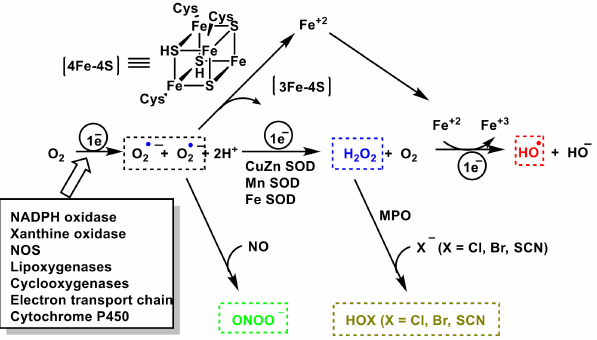
Figure 1. Chemical and enzymatic reactions generating ROS, RNS, and RHS.